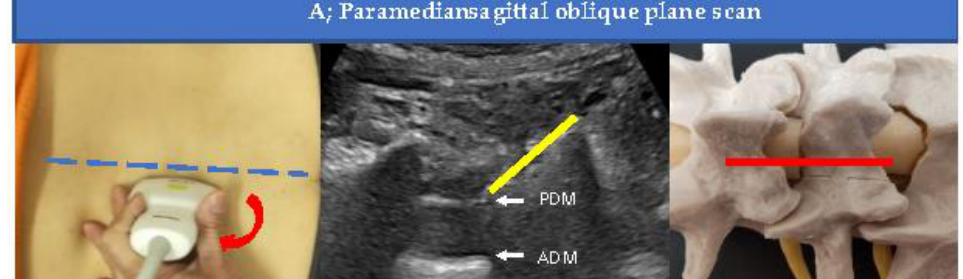
Figure 2. Panoramic paramedian sagittal oblique sonogram of the lumbar and lumbosacral junc- tions. The posterior surface of the sacrum was identified as a flat hyperechoic band with an acoustic shadow anterior to it. The gap between the sacrum and lamina of L5 is the L5/S1 intervertebral space. The L4/L5 and L3/L4 intervertebral spaces were identified by counting upward. The image in the inset shows the reconstruction of the computed tomography lumbar spine image. Abbrevia- tions: L, lumbar.